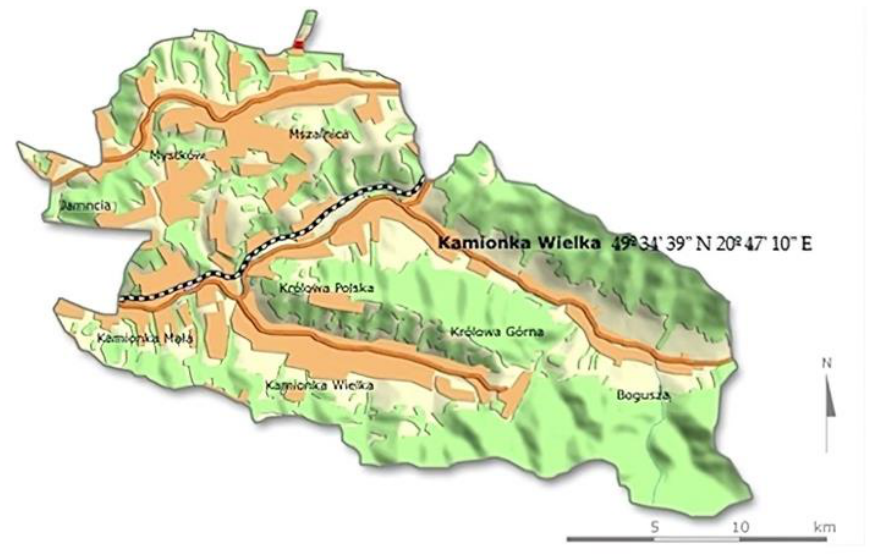
Figure 2. Location of Kamionka Wielka .